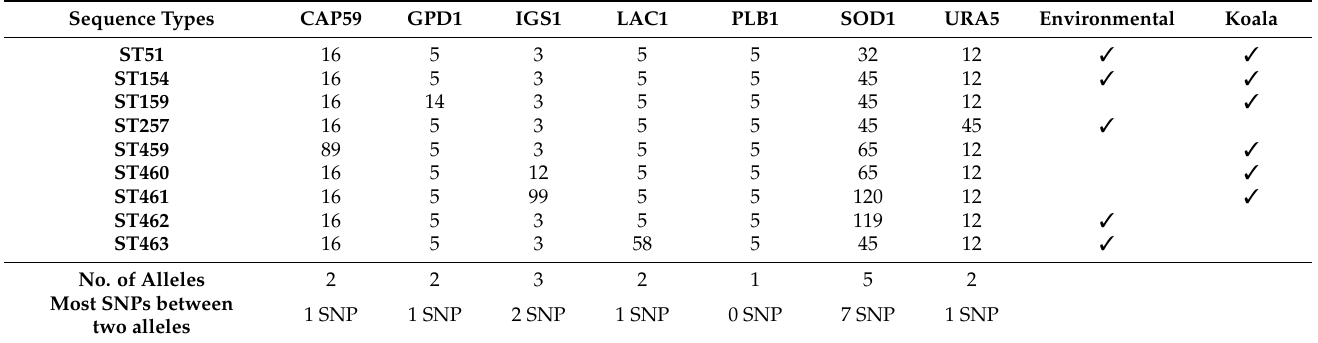
Table 2. Sequence types (ST) isolated, with the corresponding loci allele numbers, their presence in environmental or koala isolates, the number of alleles, and the total number of SNPs found at each locus.